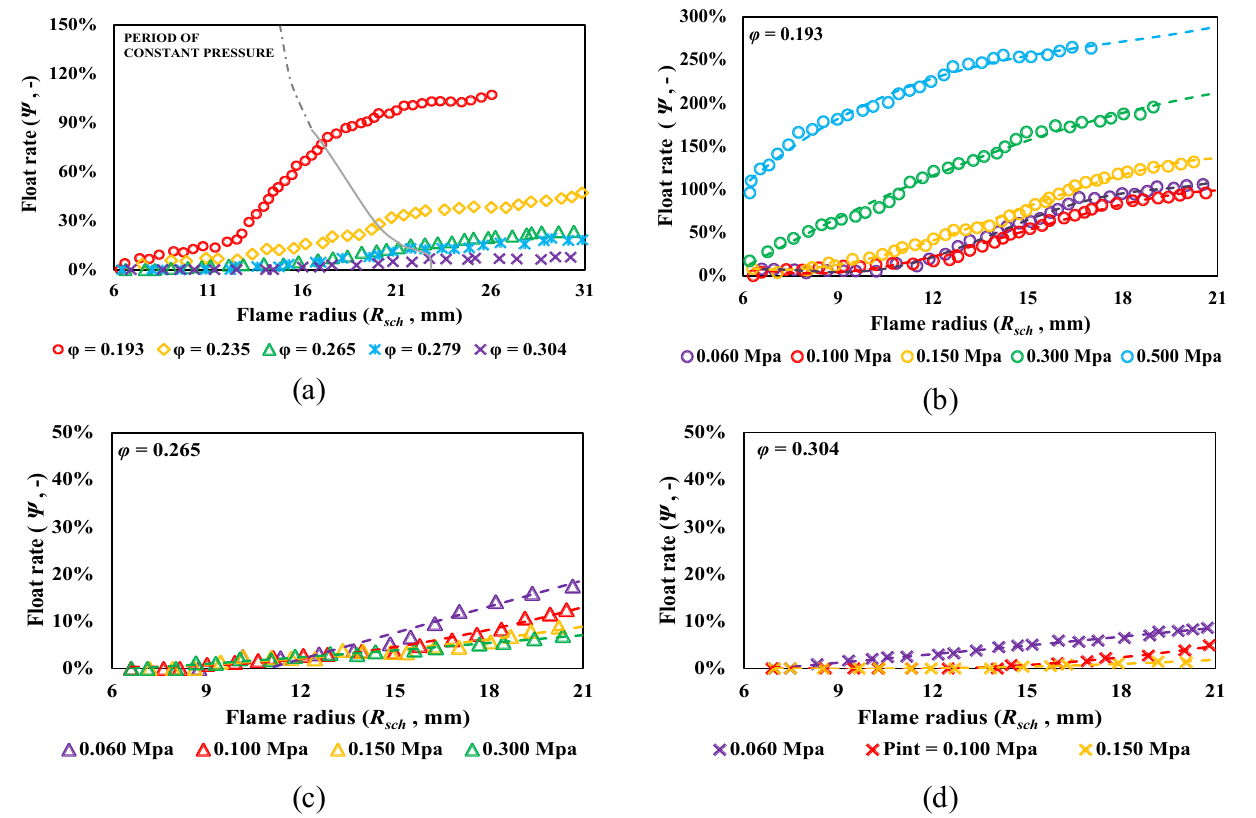
Figure 7. Variation of Float Rate with flame radius: ( a ) with different equivalence ratios under atmospheric pressure; ( b ) with φ = 0.193 under different initial pressures; ( c ) with φ = 0.265 under different initial pressures; and ( d ) with φ = 0.304 under different initial